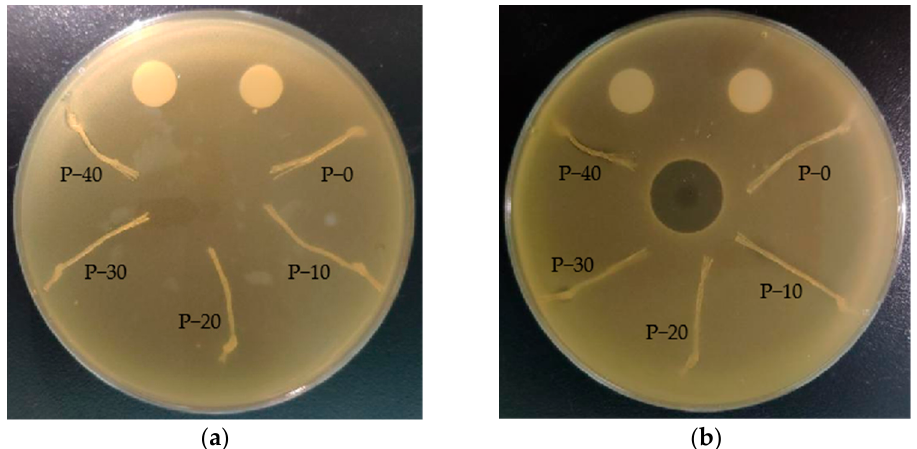
Figure 9. Pictures of the inhibition zone of PP − g − PHMG/PP − blended monofilaments against ( a ) Staphylococcus aureus and ( b ) Escherichia coli .